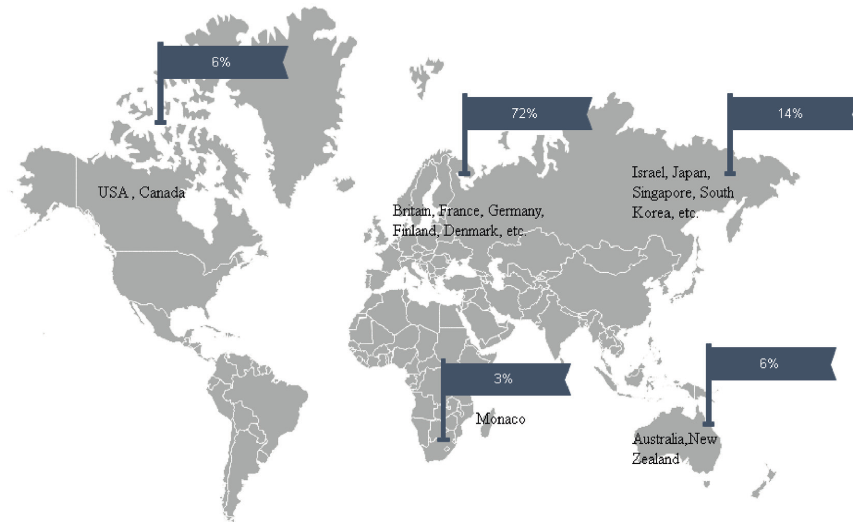
Figure 1: The distribution map of the world’s leading e-government development nations and regions in 2018.